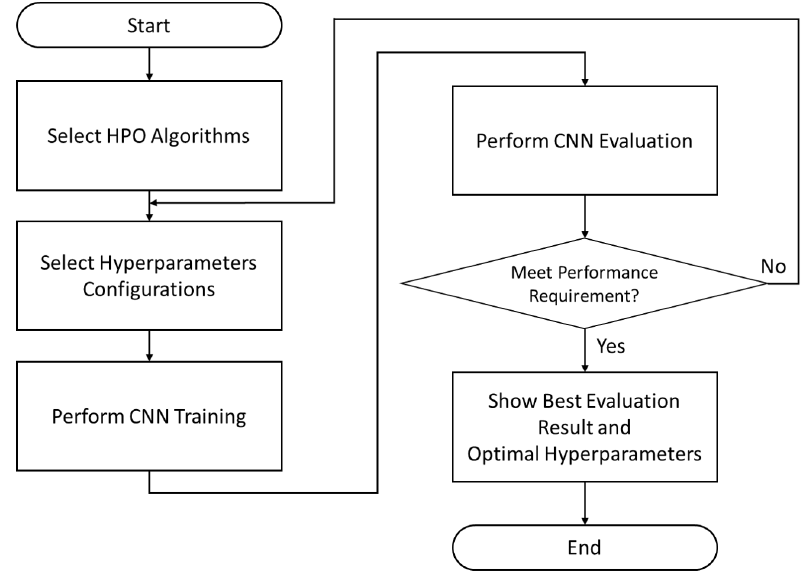
Figure 6. A general search loop of HPO implementation in CNN stage of SO-ConvESN. Every optimization run loop will train a CNN based on the selected hyperparameters and evaluate the recognition accuracy based on the training and validation datasets. best-performing configuration and the corresponding accuracy are the outcomes of the search